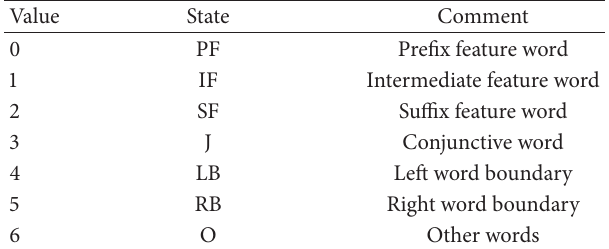
Algorithm 1 generates a transfer function for reinforcement